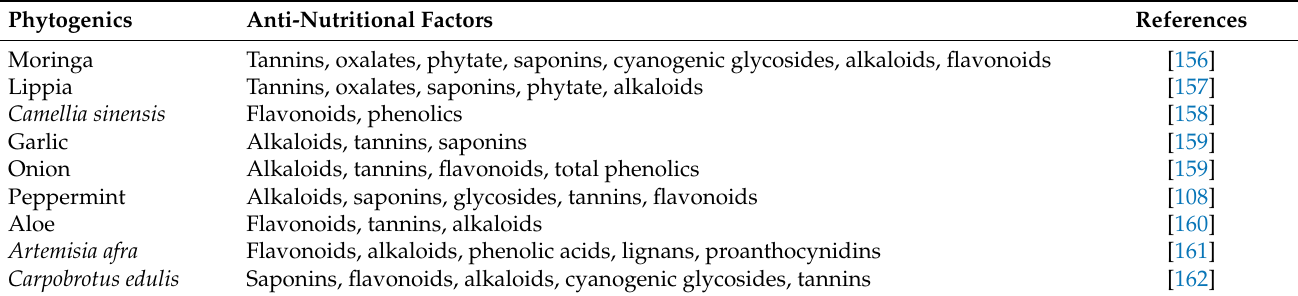
Table 1. Anti-nutritional factors present in selected plants used in poultry